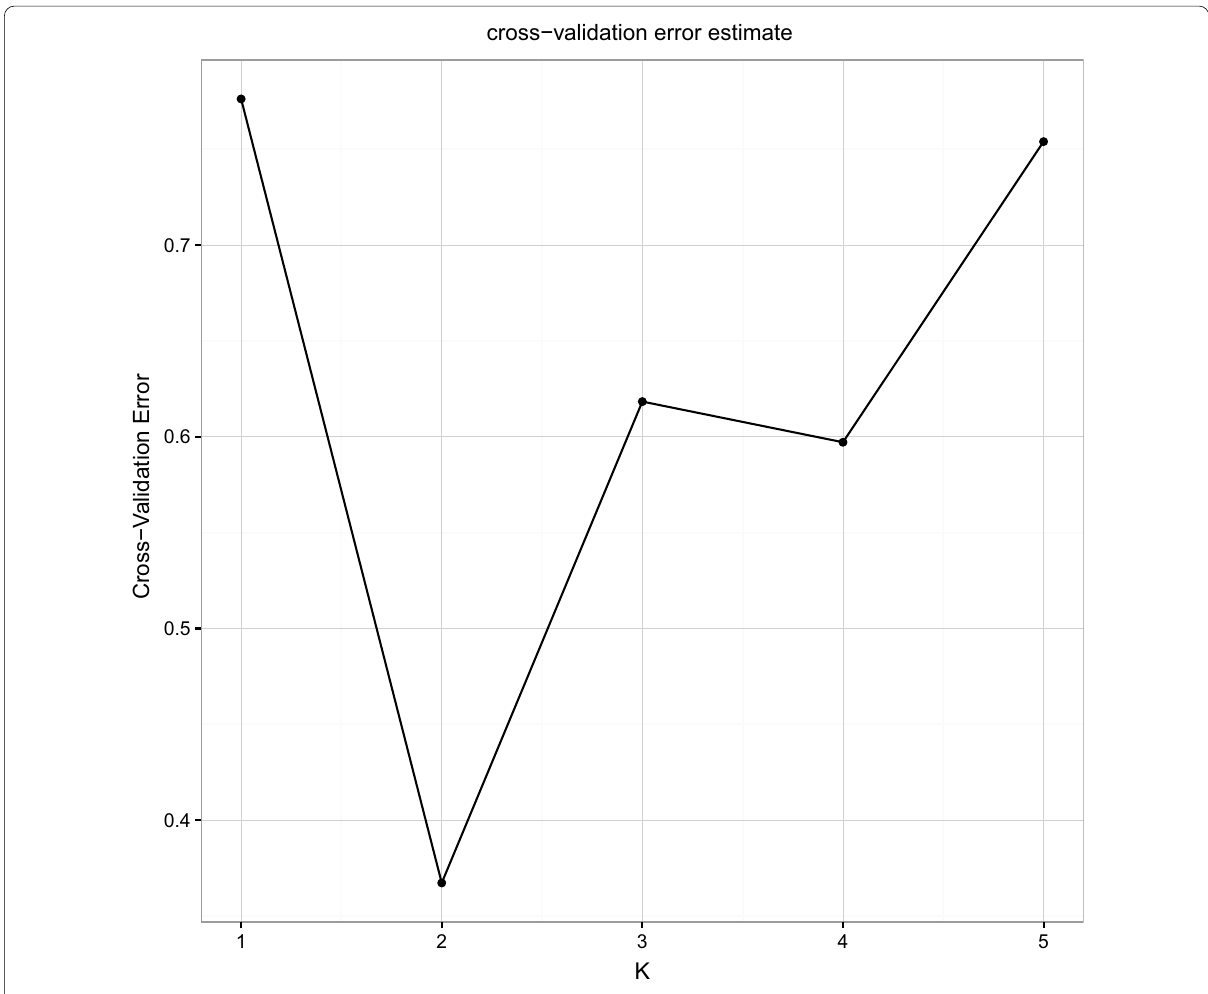
Fig. 4 Analysis of the cross validation error corresponding to different K